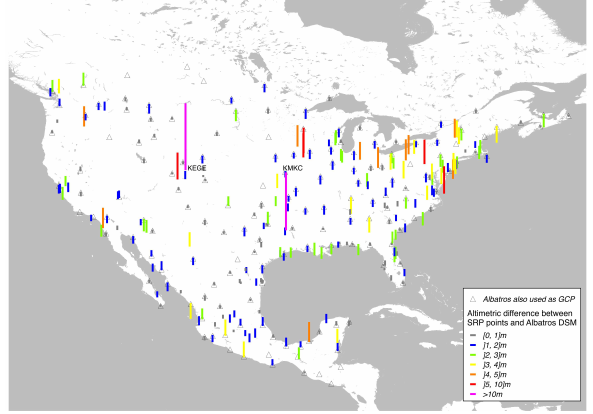
Figure 6. Altimetric check of SPOT 6/7 bundle adjustment KEGE and KMKC airports high altimetric differences are due to changes between Albatros Pléiades and SPOT 6/7 (airport duel tank), both data are correct